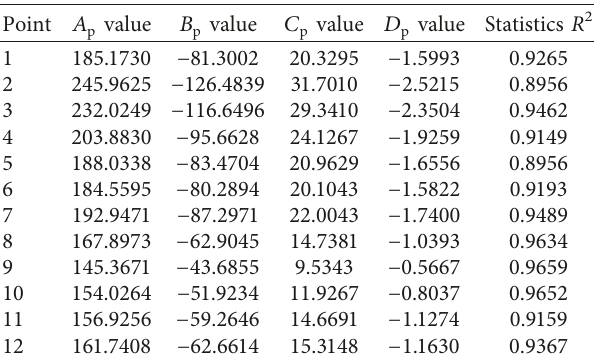
Table 4: Fit parameters between radiation noise and